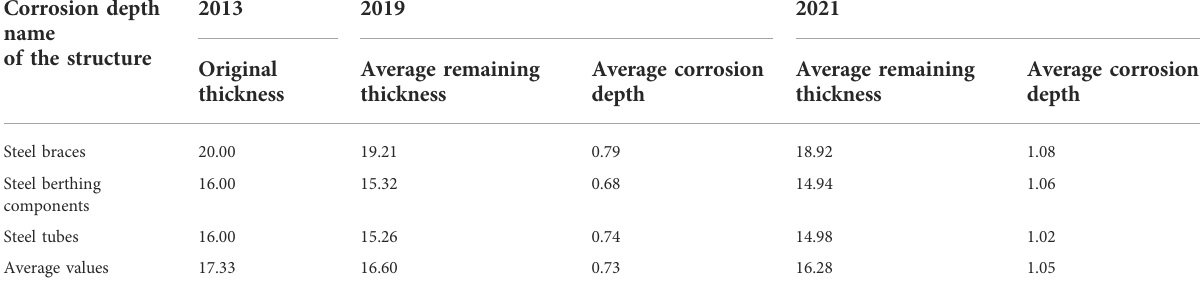
TABLE 2 Steel corrosion results measured at a certain wharf in the upper reaches of Yangtze River units: